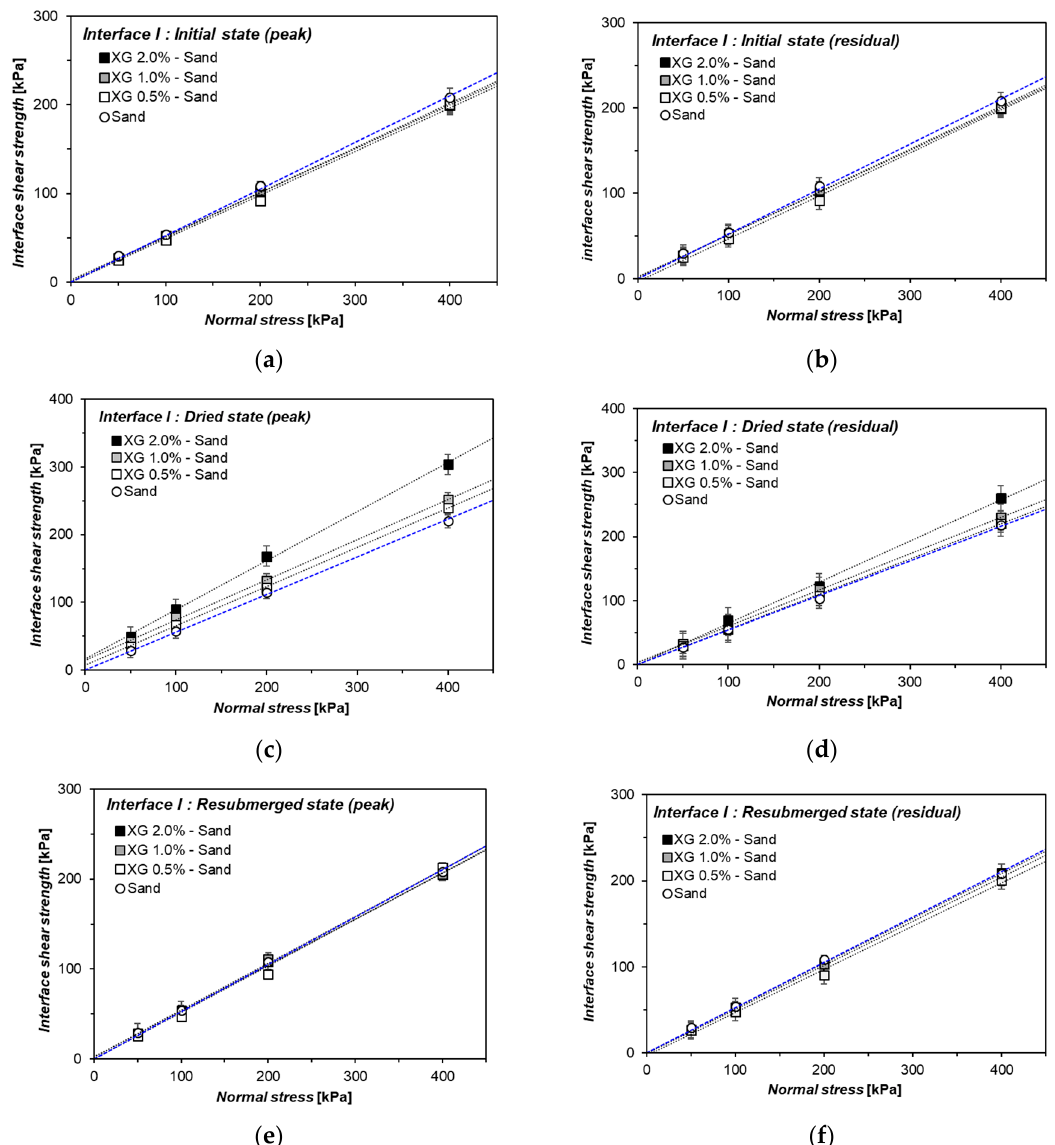
Figure 8. Peak and residual strengths of xanthan gum-treated sand shearing at interface without asperities ( Interface I ): ( a , b ) initial condition; ( c , d ) dry condition; ( e , f ) resubmerged condition. Table 5. Mohr–Coulomb failure parameters determined from linear regression ( Interface I ).